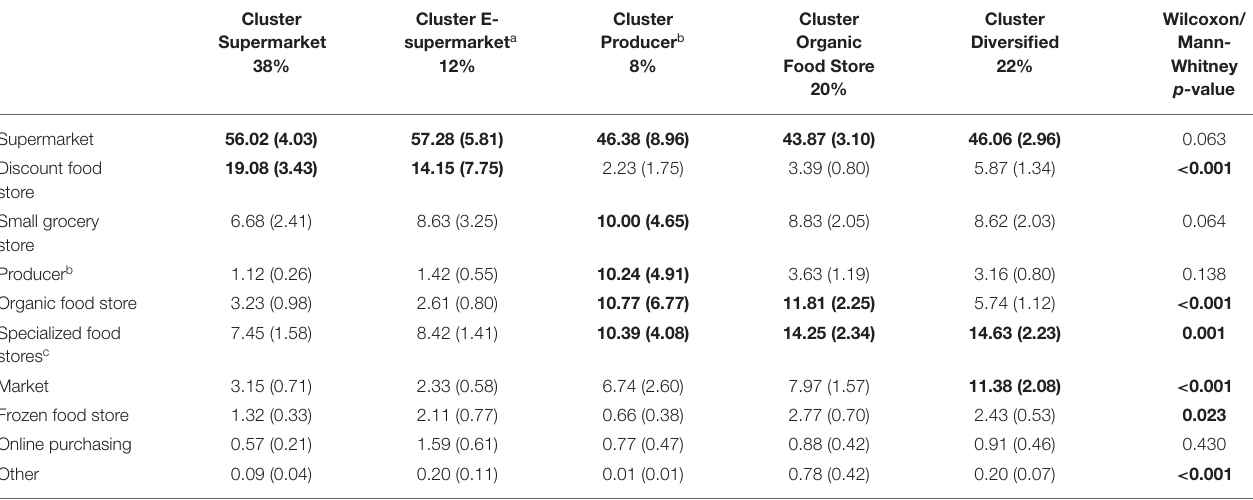
TABLE 2 | Mean share of expenses before lockdown by food supply source for each